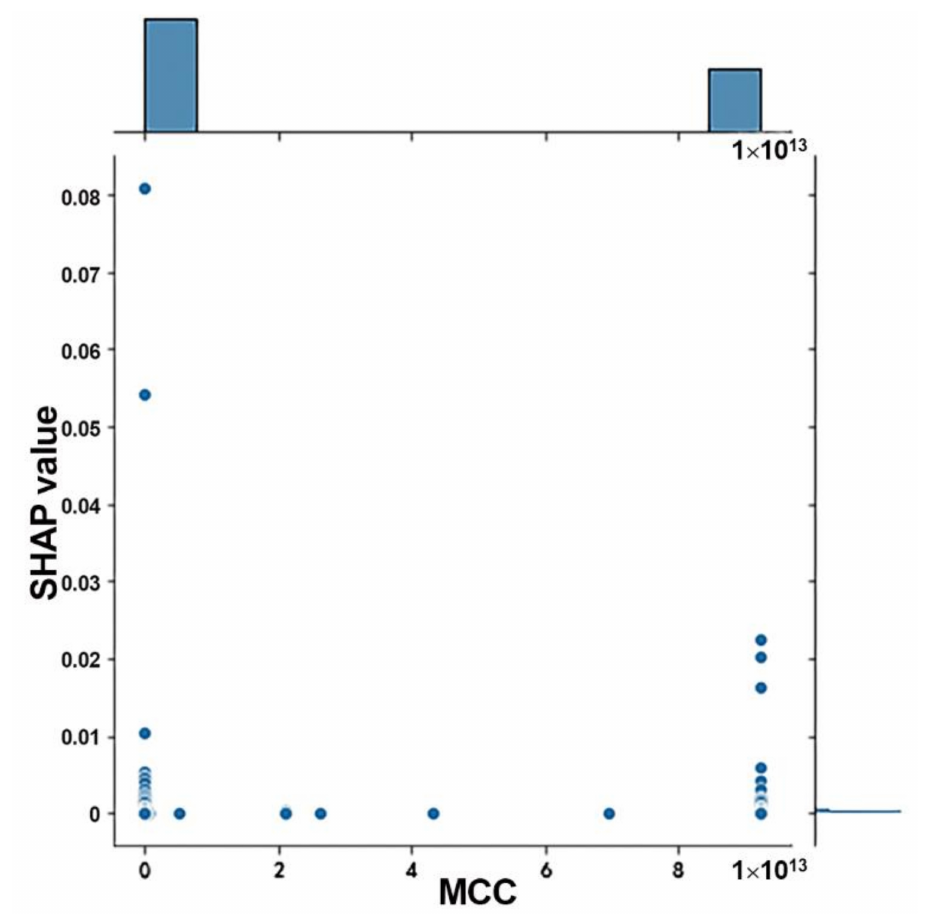
Figure 5. The joint distribution of SHAP and MCC values. MRNAs are mainly clustered in two